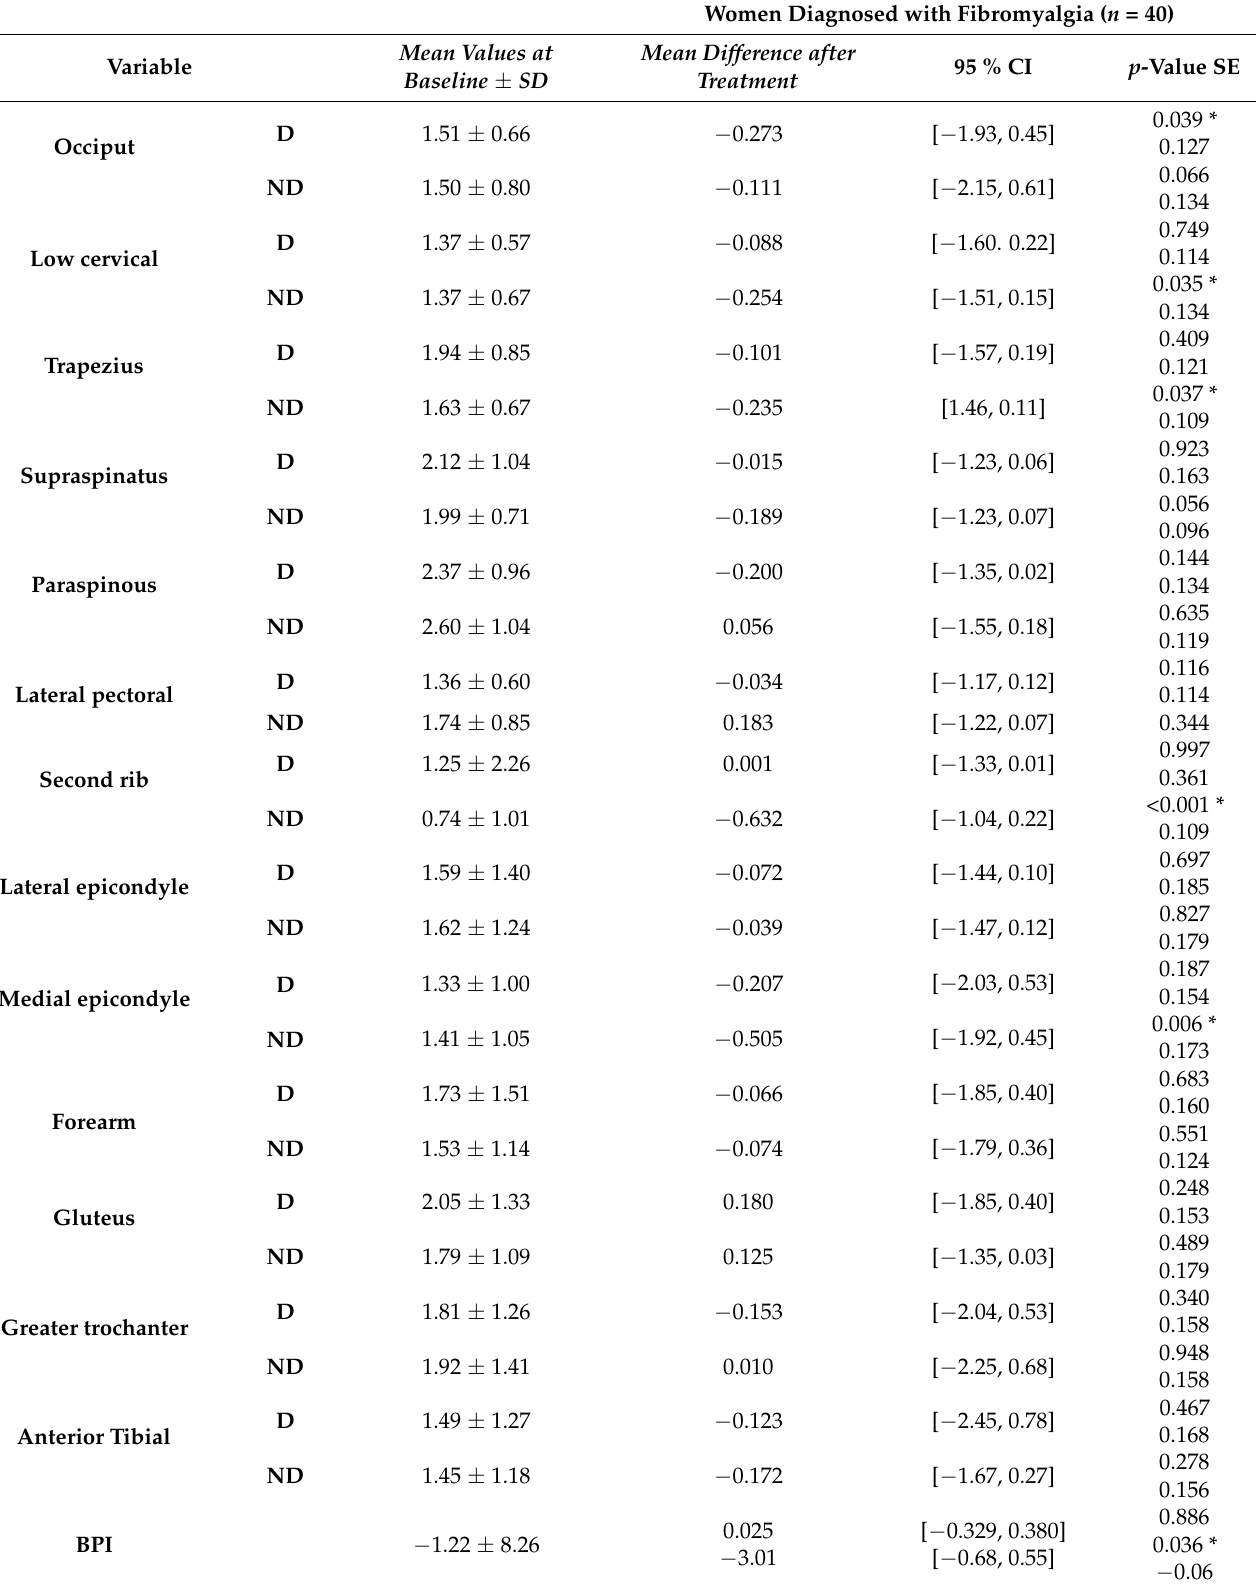
Table 3. Between groups differences in PPT in tender points and BPI after the intervention